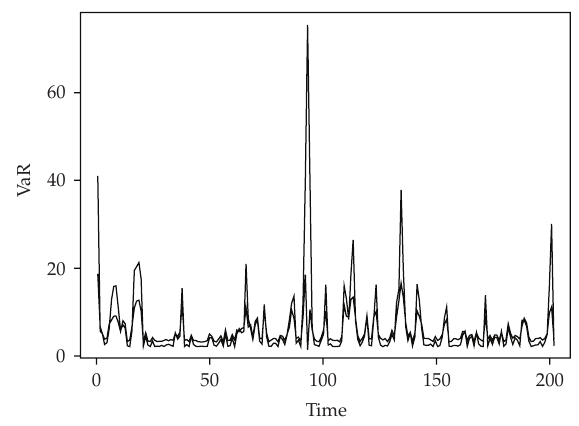
Figure 7: True and Localized